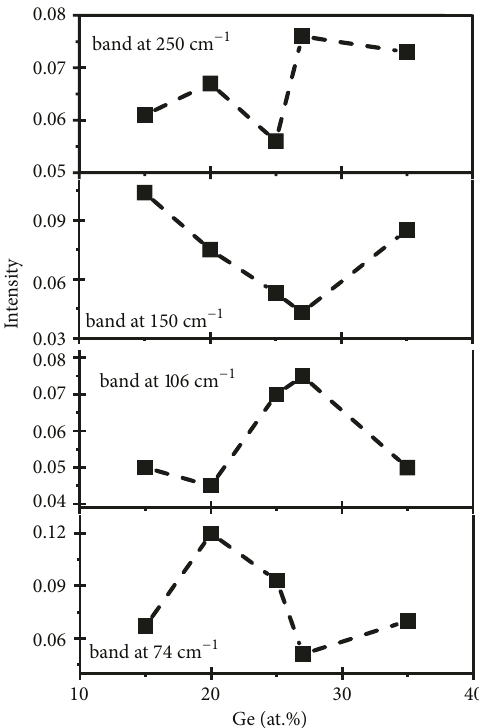
Figure 8: Dependence of bands intensity on the x values.